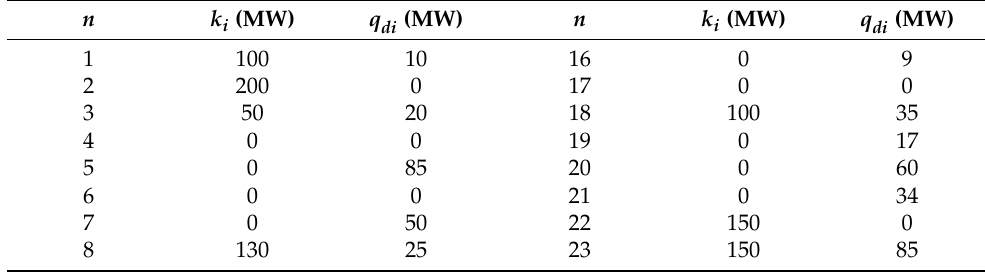
Table 2. Load and installed capacity